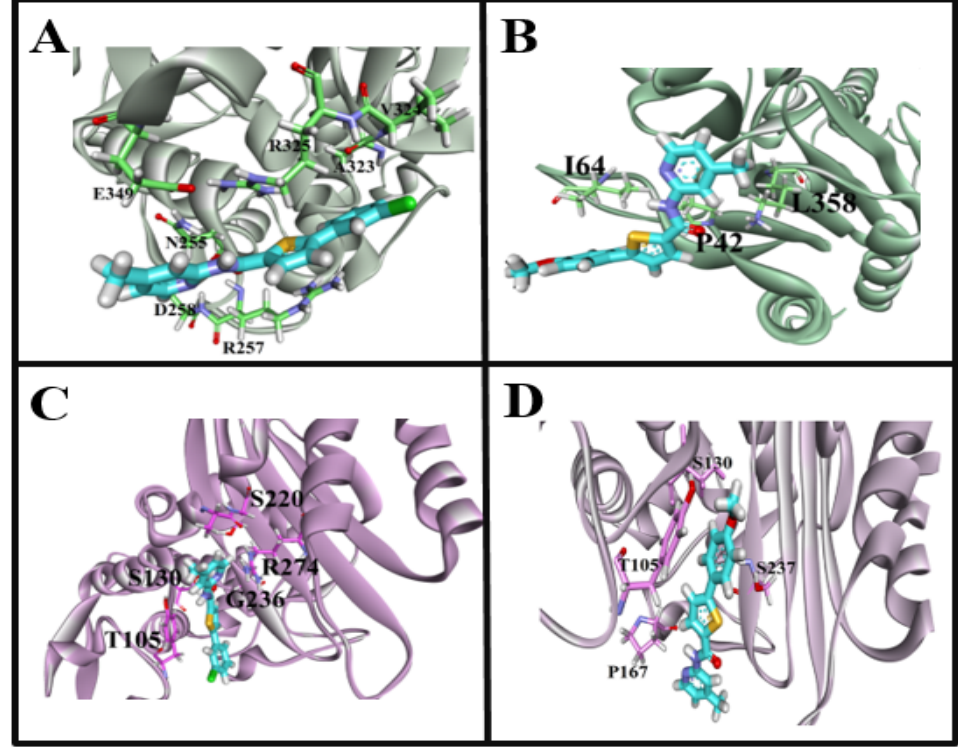
Figure 7. Interaction fingerprints of target receptor with the synthesized carboxamide derivatives.